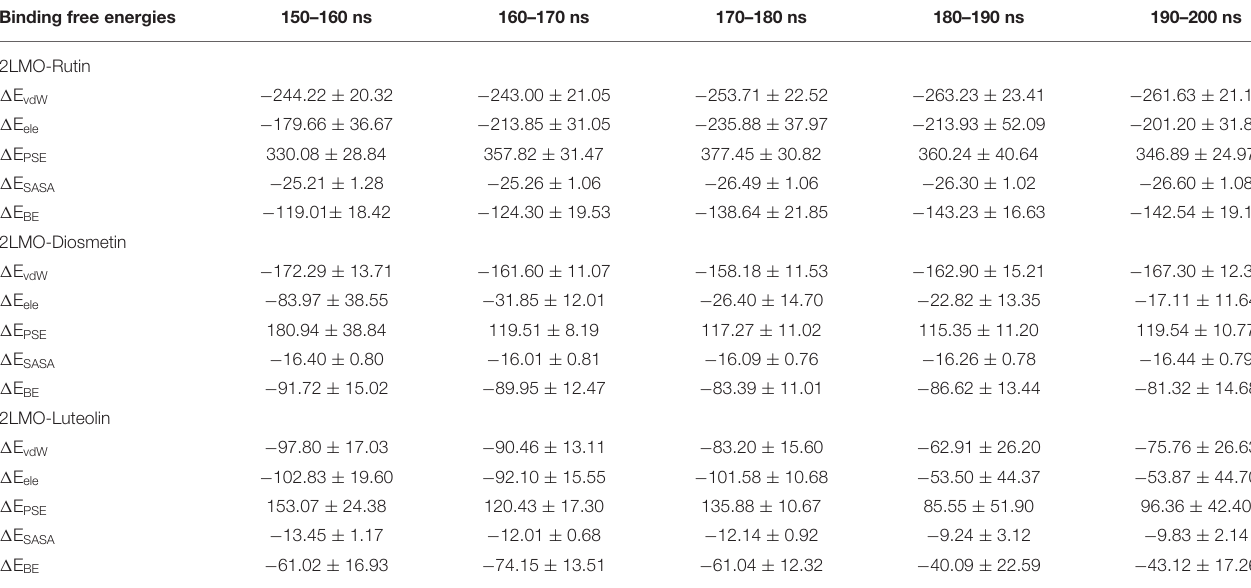
TABLE 5 | Binding free energies (kJ/mol) determined by MM-PBSA calculations of the last 50 ns of trajectories of 2LMO in complex with Rutin, Diosmetin, and Luteolin. Binding free energies